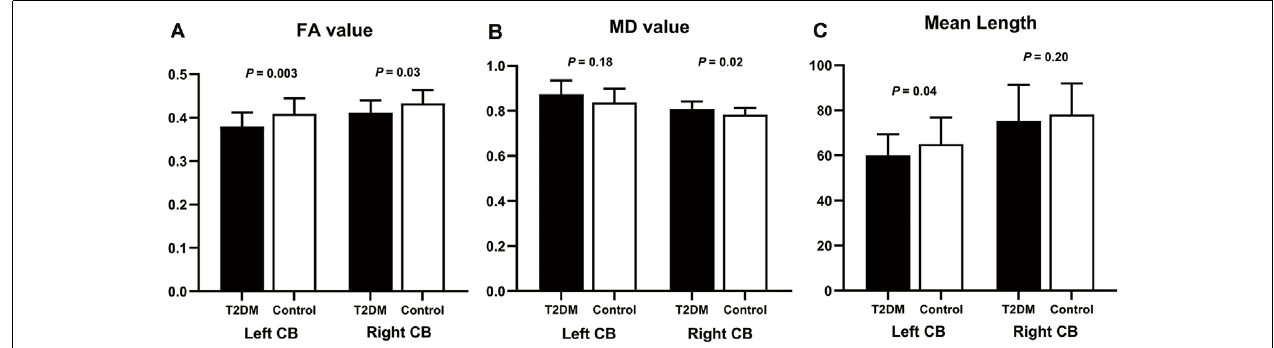
FIGURE 3 | Group differences of diffusion measurements in bilateral CB. The comparison used age, sex, education, and WMH as covariates. (A) In the T2DM group, FA values were significantly decreased in bilateral CB. (B) MD values were higher in the T2DM group, but the significance in the left CB did not remain after controlling for the covariates. (C) T2DM patients had shorter fiber length compared to the controls, but only the difference in the left CB was significant after introducing the covariates. CB, cingulum bundle; FA, fractional anisotropy; MD, mean diffusivity. The error bars represent the standard deviation.